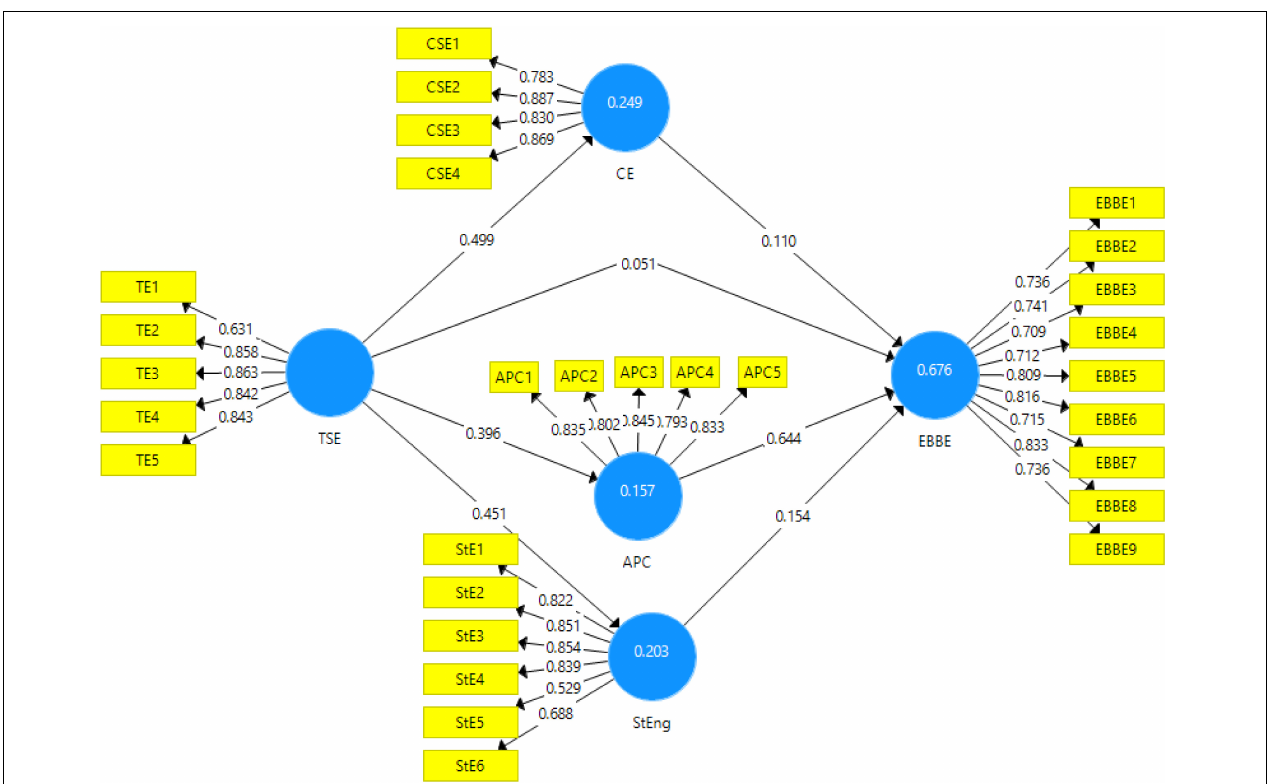
FIGURE 2 | Output of measurement